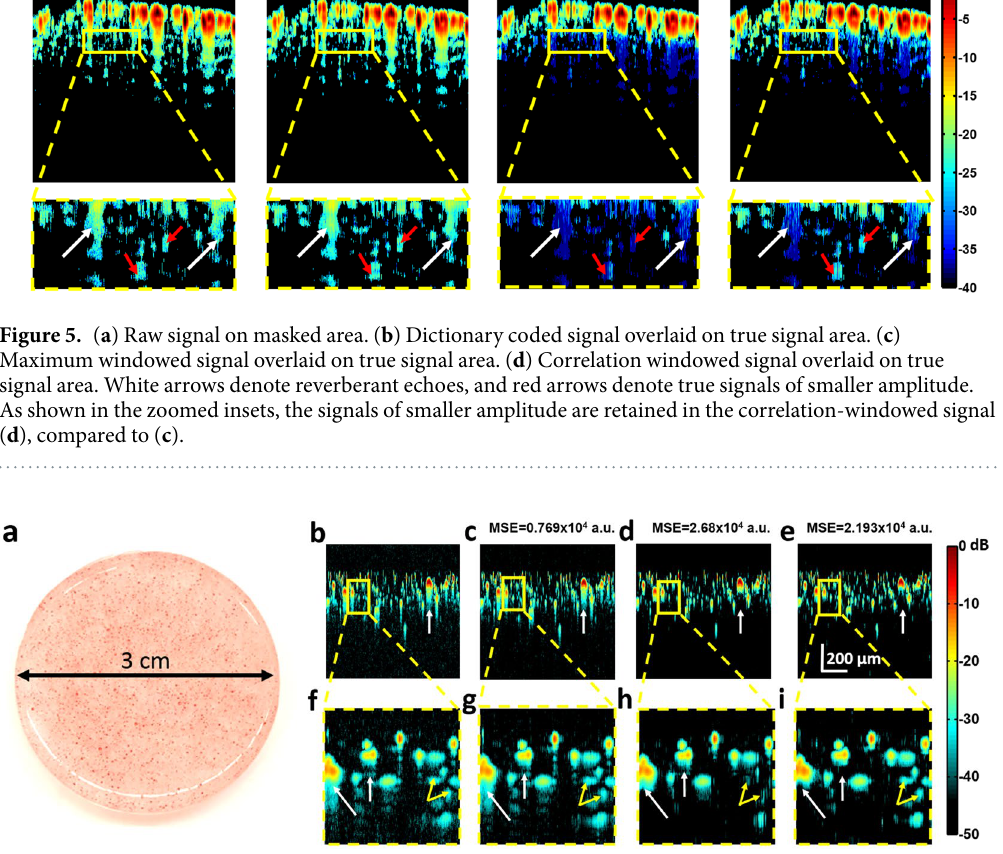
Figure 6. ( a ) In vitro PDMS phantom. ( b ) Representative B-scan (Raw signal) ( c ) Dictionary Coded B-scan, ( d ) Reverberation removed by maximum signal window. ( e ) Reverberation removed by correlation window. ( f – i ). Corresponding zoomed insets of ( b – e ). Removed reverberation is indicated by the white arrow in zoomed insets ( h , i ), retained small signals indicated by the yellow